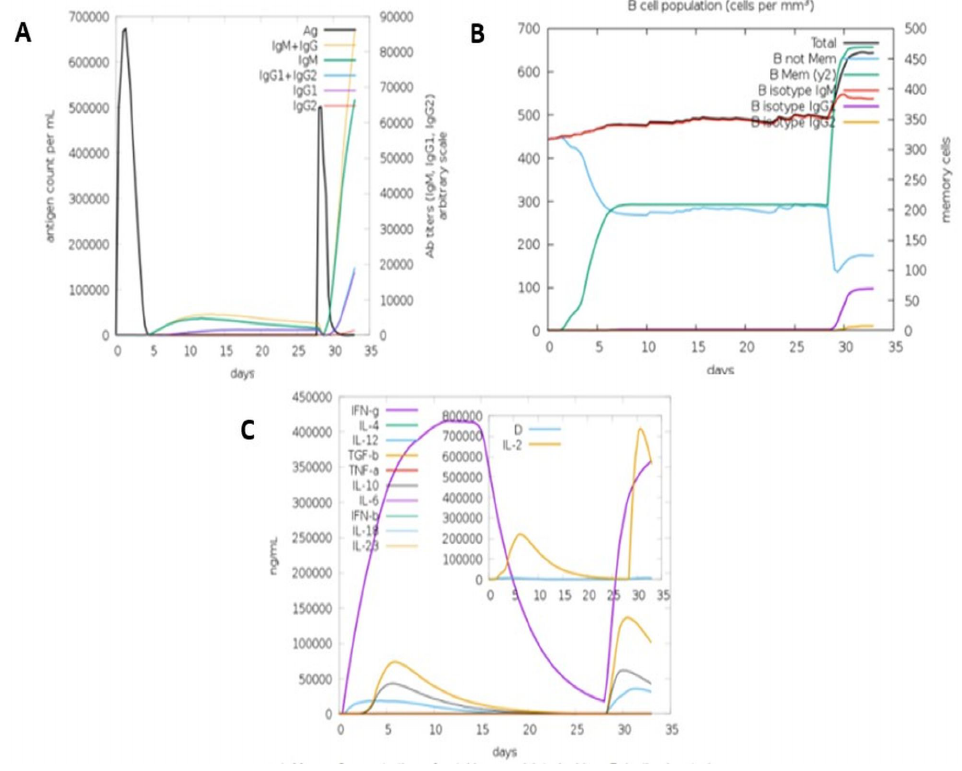
Figure 7. The ( A ) the induction of antibody responses after 2 doses of MEV vaccine. ( B ) The induction of B-cell population. ( C ) The expression of cytokines following MEV vaccine administration.